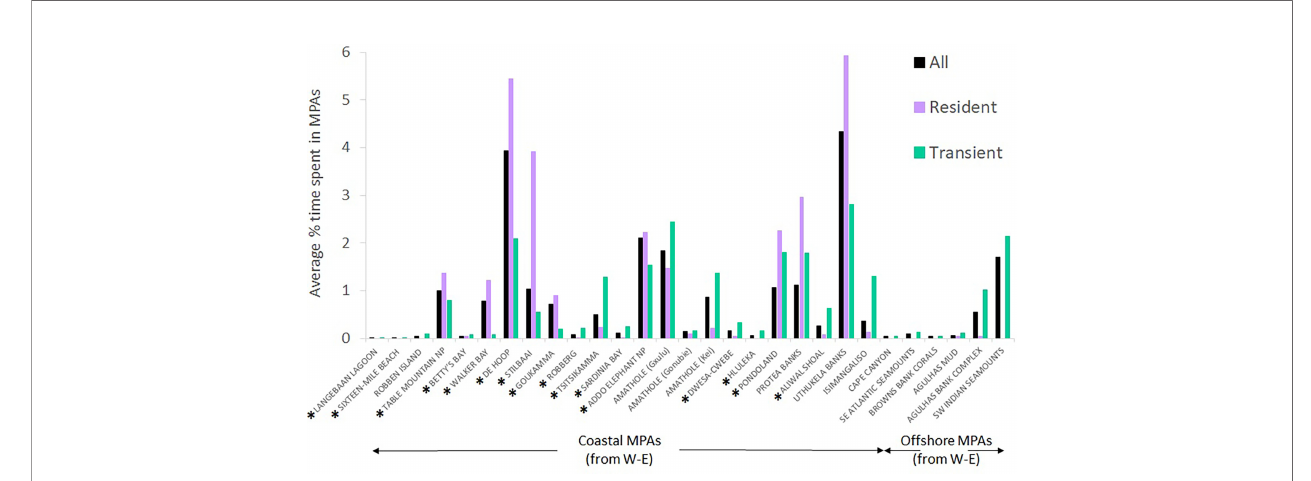
FIGURE 10 | The average percentage of time spent by white sharks Carcharodon carcharias in the 29 marine protected areas they visited, depending on whether data were combined (all), or divided into resident versus transient states. MPAs in existence during tracking are indicated with a *; others were proclaimed in